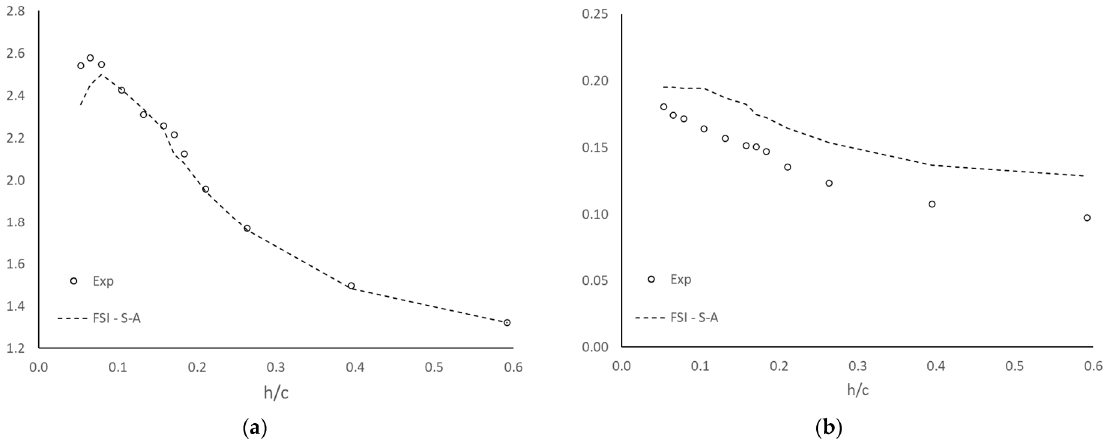
Figure 14. Aerodynamic forces of double-element wing in ground proximity with various heights: ( a ) lift coefficient, ( b ) drag